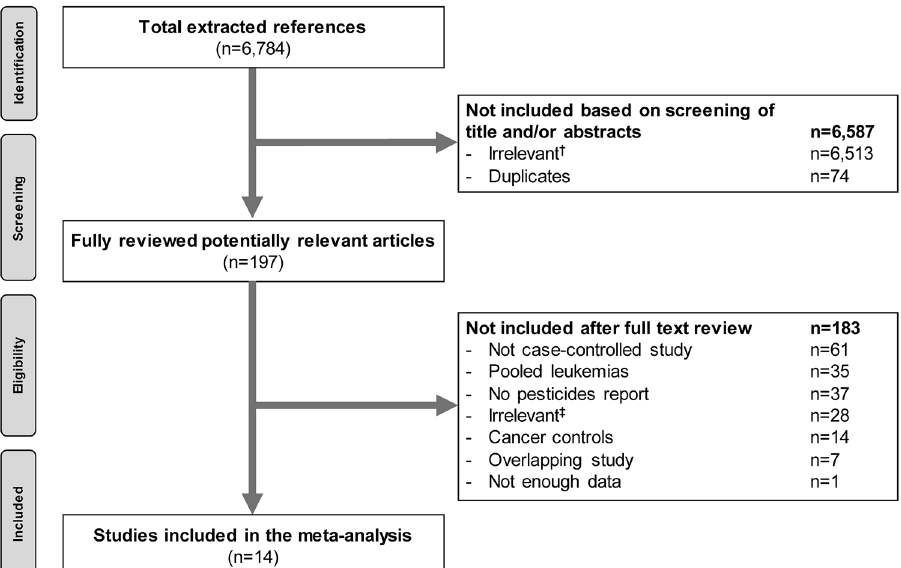
Figure 1. Flow diagram of study selection. † in vitro / in vivo studies, case reports, non-English publications, cohort description, non-acute myeloid leukemia (AML) patients, pooled analysis of different leukemia subtypes. ‡ in vitro studies, reviews, case report, erratum, conference paper, death as outcome, missing data on the outcome and exposure, non-AML patients. References are available in Supplementary Datasets 1 and